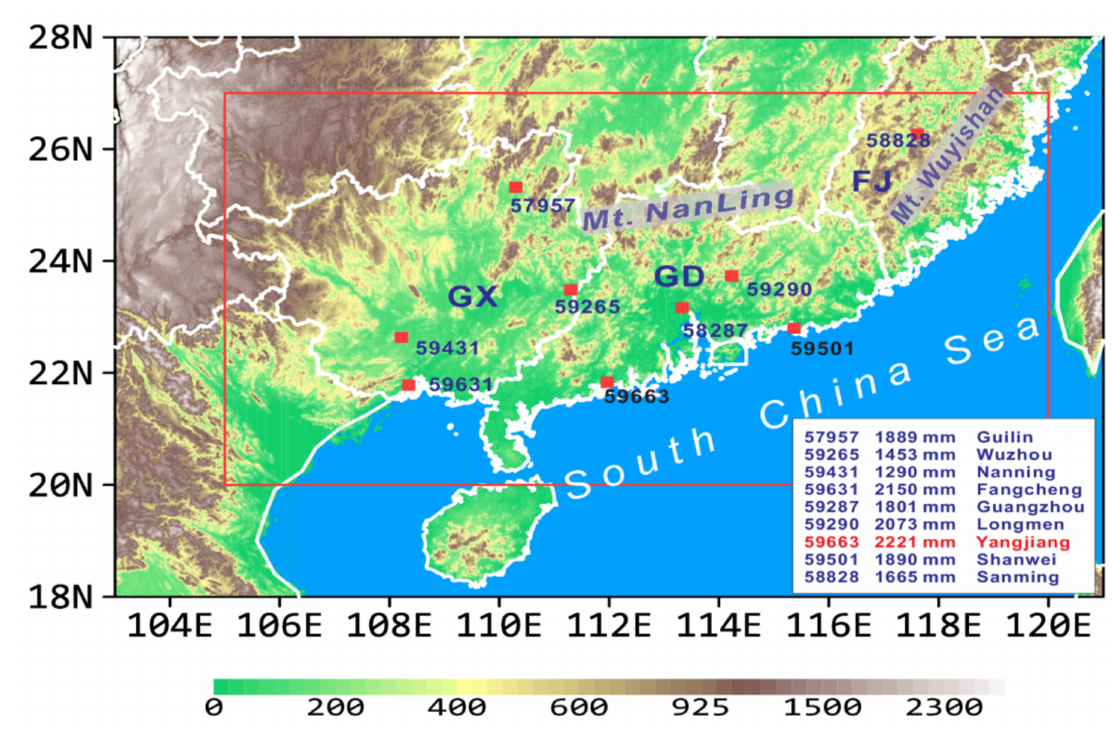
Figure 1. Distribution of topography (shaded, m) and some related national surface stations (red dots with identifications) over South China. The inner red frame denotes the region of interest (20–27 ◦ N, 105–120 ◦ E) for the present study. The top nine annual precipitation stations (with their identifiers) averaged during 1981–2010 are given with their corresponding amounts listed in the bottom right box. Letters, “GX”, “GD”, and “FJ” denote the province of Guangxi, Guangdong and Fujian, respectively, similarly for the rest of